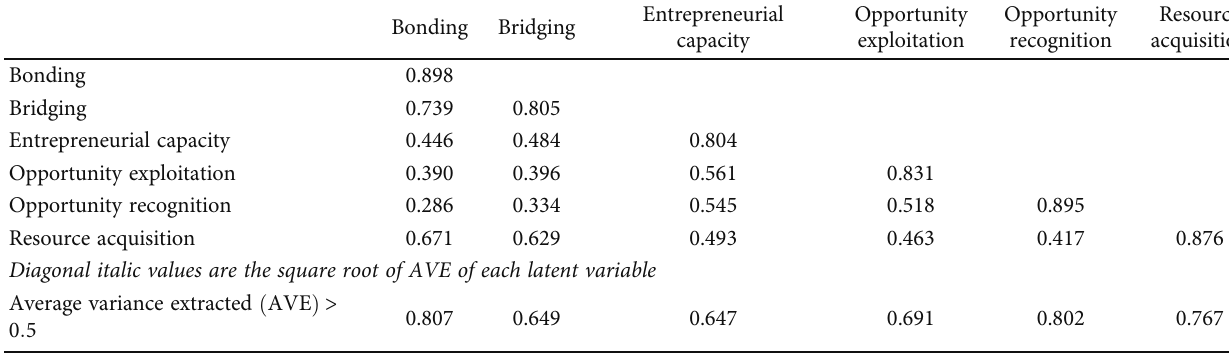
Table 3: Reliability and validity of the measurement model.